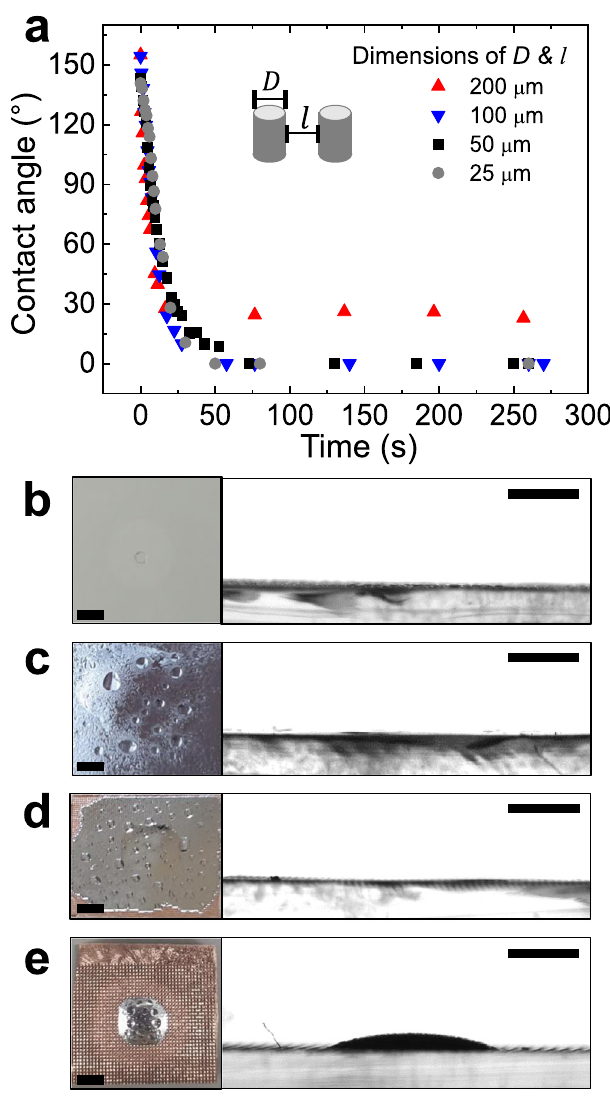
Fig. 2 | Effect of the dimensions of post patterns on the contact angles and imbibition of a droplet of EGaIn. a Time-dependent change in contact angles of EGaInontheCu/PDMSsurfaceswithvariousdimensionsofpostsafterexposureto HCl vapor. b – e Top and side views of EGaIn wetting. b D = l =25 μ m, r =1.78. c D = l =50 μ m, r =1.39. d D = l =100 μ m, r =1.20. e D = l =200 μ m, r =1.10. The height of all the posts is 25 μ m. The images were captured at least 15min after the